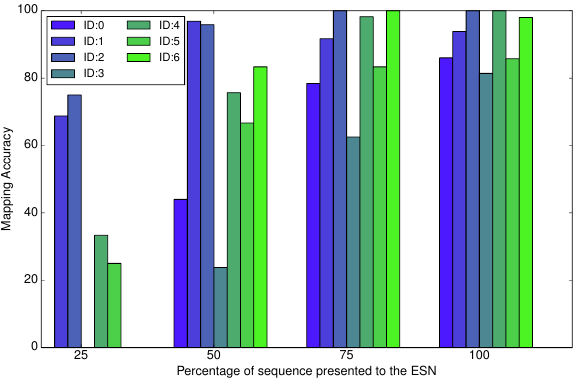
Figure 6. Accuracy of the ESN for partially observed inputs. Each colour represents an input sequence. The bars are grouped in four categories, each one representing the percentage of the signal presented to the